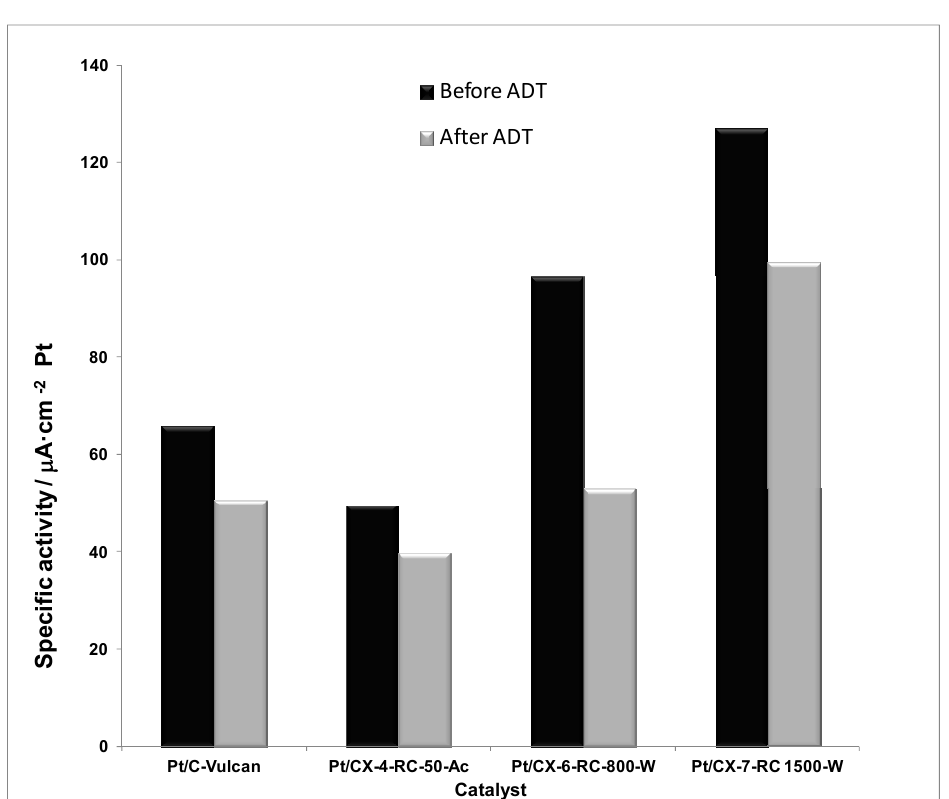
Figure 11. Specific activity at 0.80 V vs . RHE (half-cell, oxygen fed, 0.5 M H before and after accelerated degradation tests